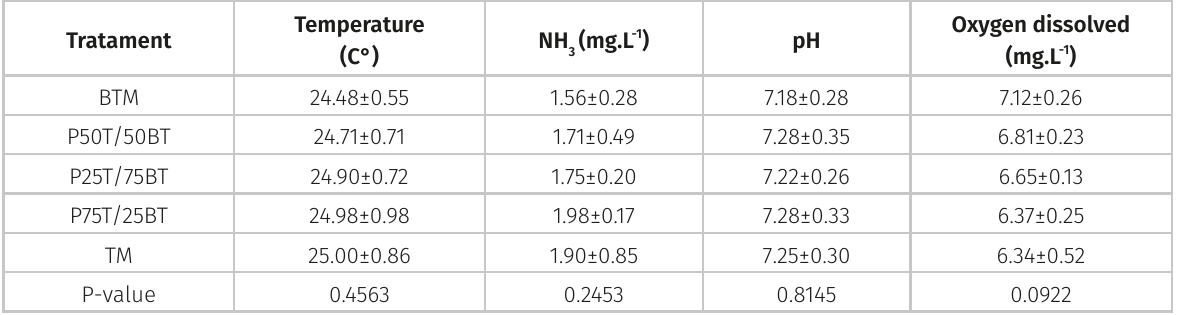
Table I. Water quality of polyculture (P) between bullfrog tadpoles (BT) and Nile tilapia (T), tilapia monoculture (TM) and a bullfrog tadpole monoculture (BTM) experiment